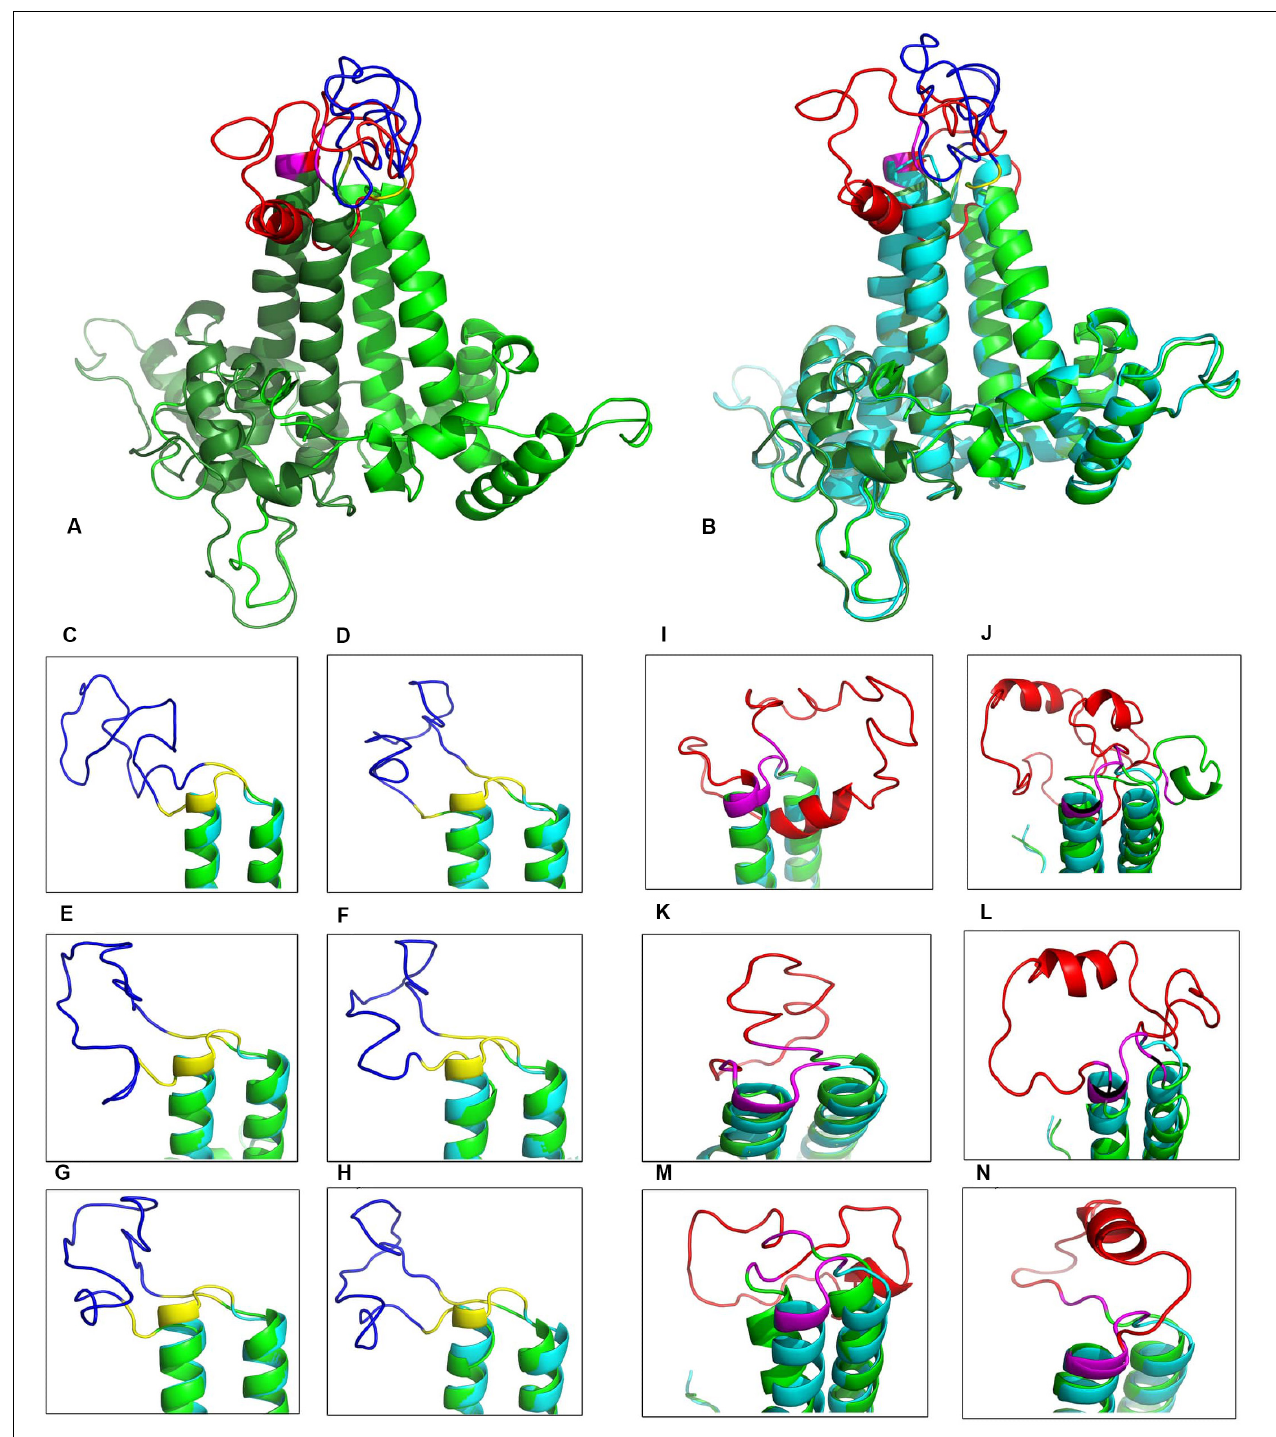
FIGURE 3 | Structural view of the designed virus-like particle (VLP)-based vaccine. (A) Overview of final stable VLP-based vaccine [insertion of 1–50 of the Myrcludex region of HBsAg in the first monomer of HBcAg ( red ) and 118–150 of the “a” determinant of HBsAg in the second monomer ( blue )]. (B) Structural alignment of the VLP-based vaccine and the HBcAg dimer in green and cyan , respectively. (C–H) Close-up view of various “a” determinant insertions in the immunodominant region (MIR) of the second monomer (118–150, 123–150, 121–147, 124–147, 121–148, and 123–148, respectively). (I–N) Close-up view of a range of Myrcludex insertions in the MIR of first the monomer (1–50, 2–48, 1–21, 9–48, 18–48, and 20–48, respectively).